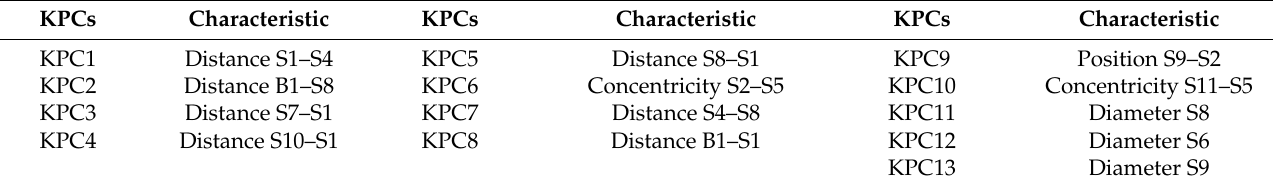
Table 2. KPCs for the part analyzed in the case study.